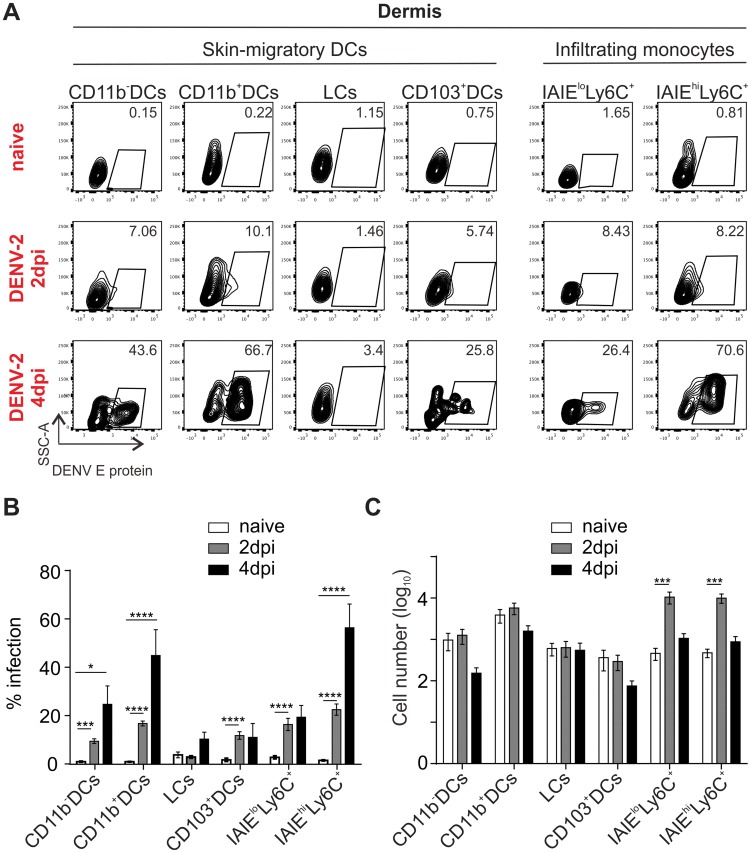

In vivo infection of migratory DCs in the skin of IFNAR−/− mice.(A) Mice were inoculated intra-dermally (i.d) with 1×106 pfu of DENV-2 D2Y98P/ear, and ears were harvested 2 and 4 days post infection. DENV E protein expression was detected by flow cytometry of skin-resident DC subsets and infiltrating monocytes (Gating strategy to identify DC subsets/monocytes shown in Figure S2) (B) Summary data of (A), 4 to 5 mice (taking the average of two ears/mouse) per group pooled from two independent experiments, mean ± SEM, analyzed with one-way ANOVA followed by Tukey's multiple comparison test, *p<0.05; **p<0.01; ***p<0.001; ****p<0.0001; non-significant differences are not indicated (C) Quantification of DCs isolated from ears at 2 and 4 dpi to address infiltration and migration of different cell subsets. Same conditions as in (B).